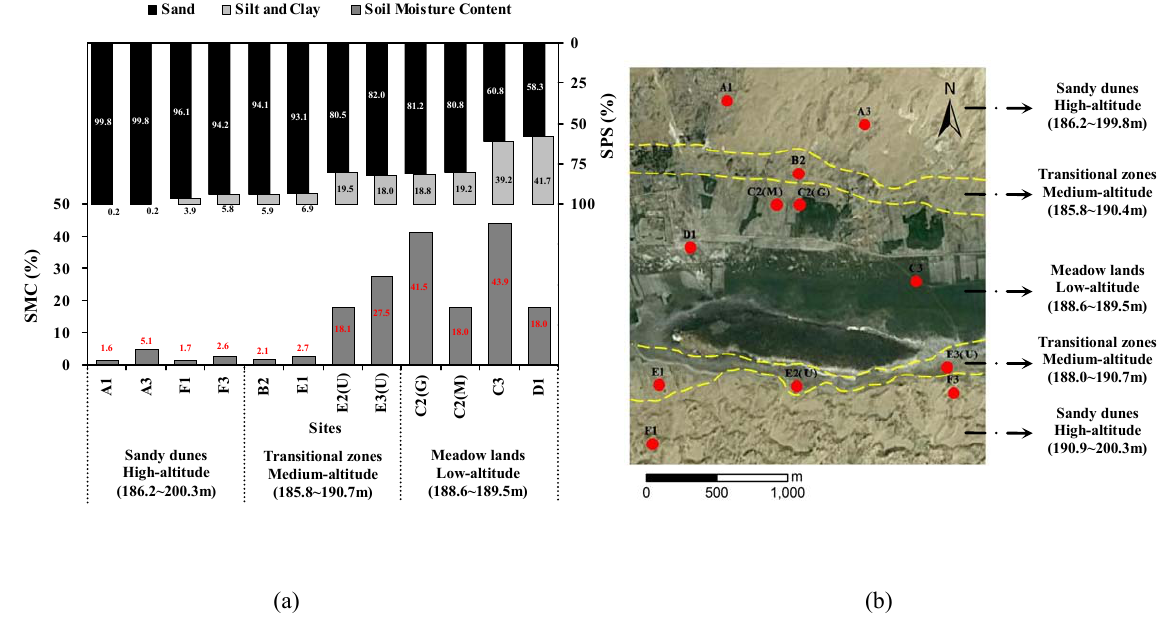
Fig. 2 (a) The mean annual soil moisture content (SMC) and soil particle size (SPS) at experiment sites (Table 2), and (b) topography of the study area, with numbers in parentheses representing elevations and the yellow dashed lines delineating the boundaries of the transitional zones. 6